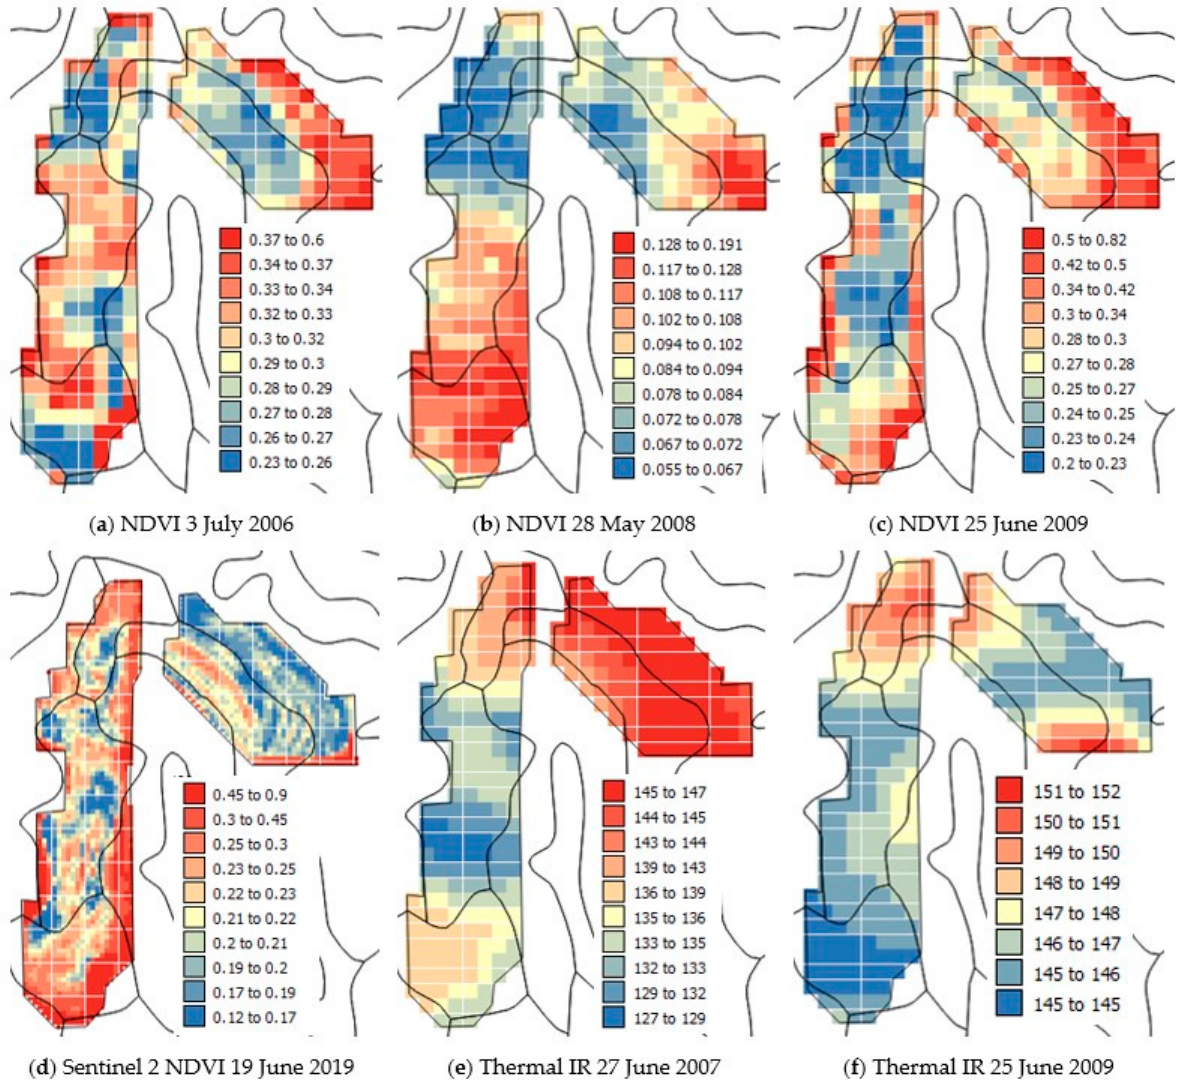
Figure 6. Pixel maps (30 m) of NDVI ( a – d ) and thermal IR ( e – f ) from LandSat ( a – c , e – f ) and Sentinel 2 ( d ) imagery on selected dates. Black lines show soil series boundaries